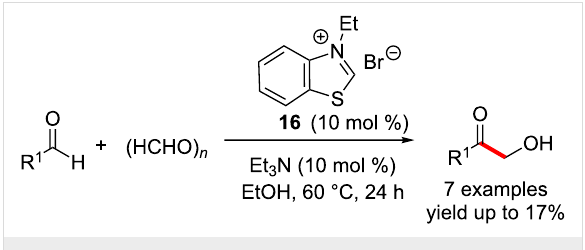
Scheme 7: Inoue’s report of cross-benzoin